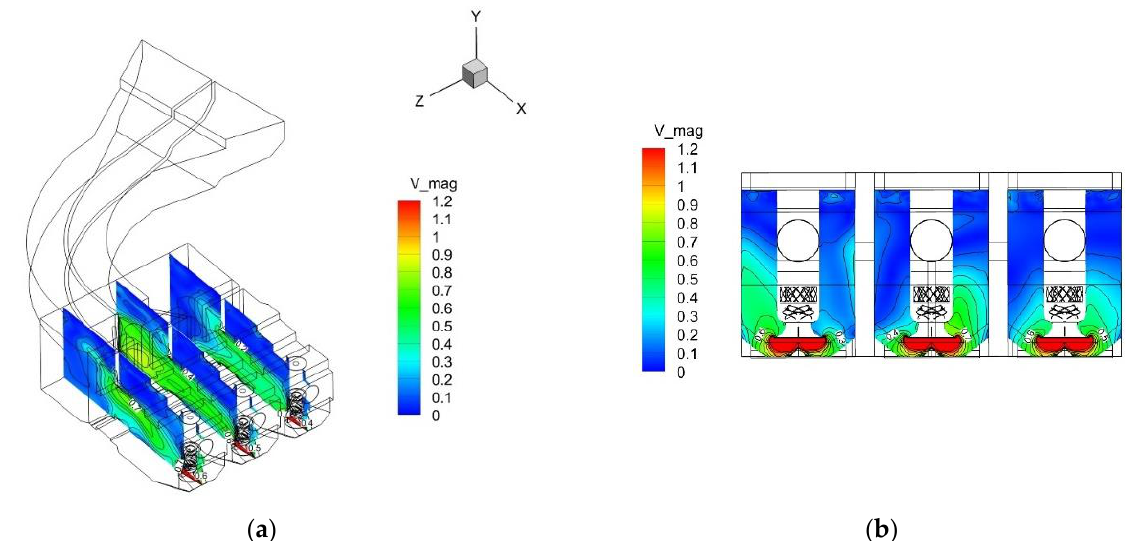
Figure 10. Plan 2 isogram of velocity. ( a ) Center section of pump body along flow direction. ( b ) Center section of pump body in vertical flow direction.